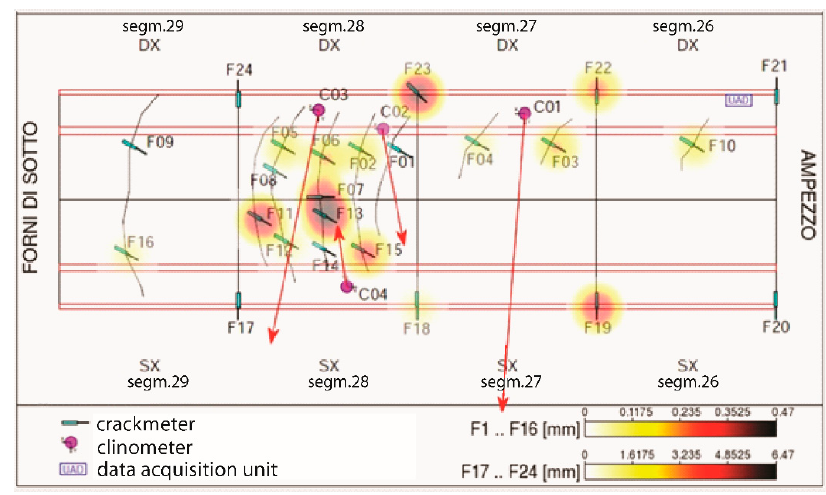
Figure 7. Screenshot of the colour/arrow map for the tunnel monitoring system in the web-based platform.